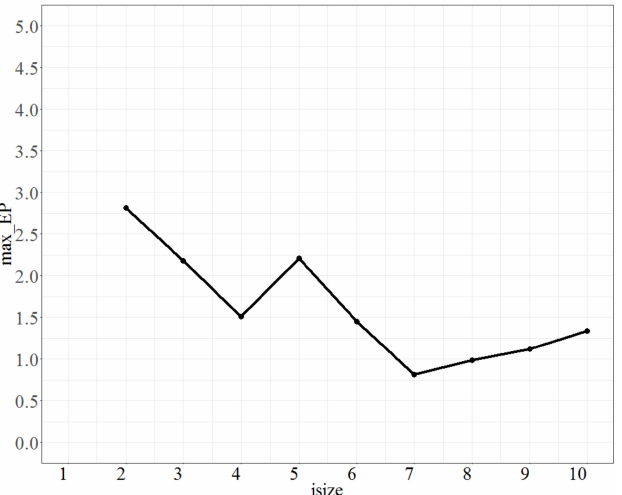
Figure 4. The max_EP plot as Isize varies.